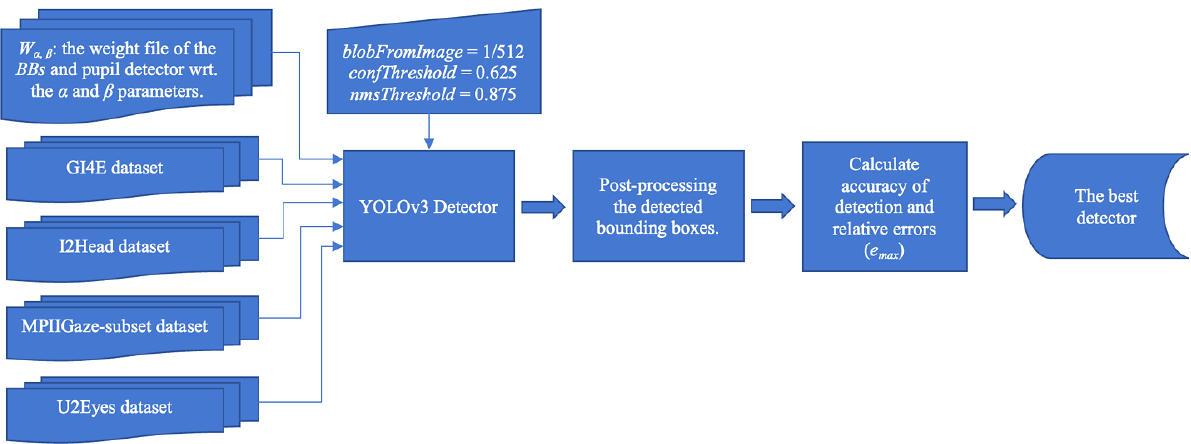
Figure 4. A summary of the steps involved in finding the best detector from a set of detectors that are trained with different combinations of α and β parameters using a variety of